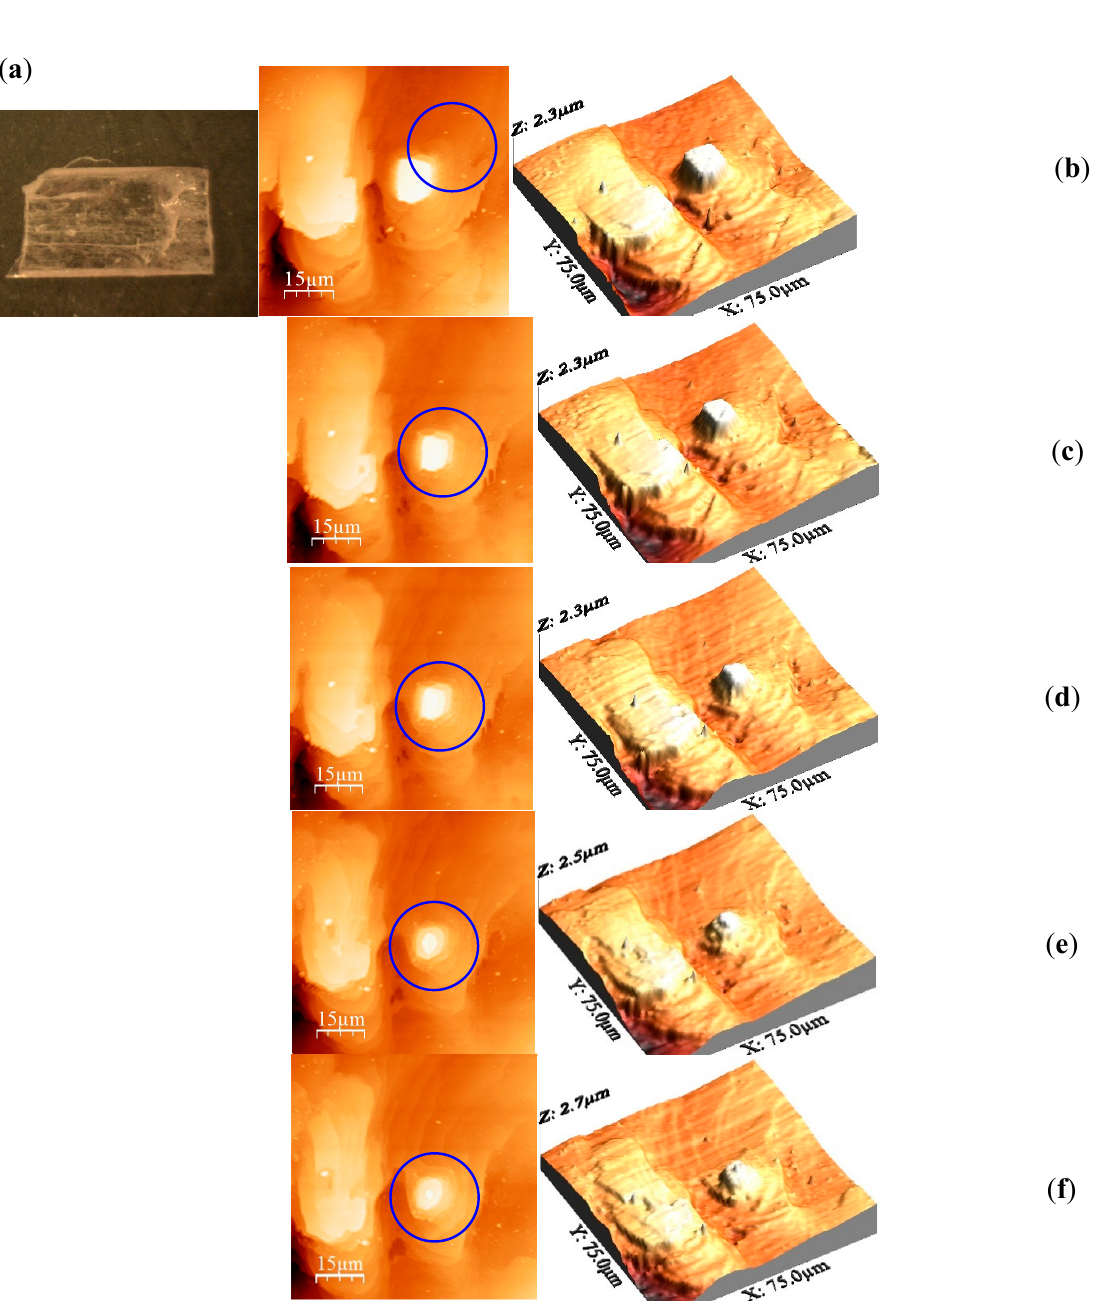
Figure 1. Optical image of TNT ( a ) and AFM final images (right) and their corresponding 3D images (left) of TNT crystal surface: ( b ) at room temperature, and heated at ( c ) 55 °C for 243 min, ( d ) 60 °C for 55 min, ( e ) 65 °C for 55 min, and ( f ) 70 °C for 30 min.